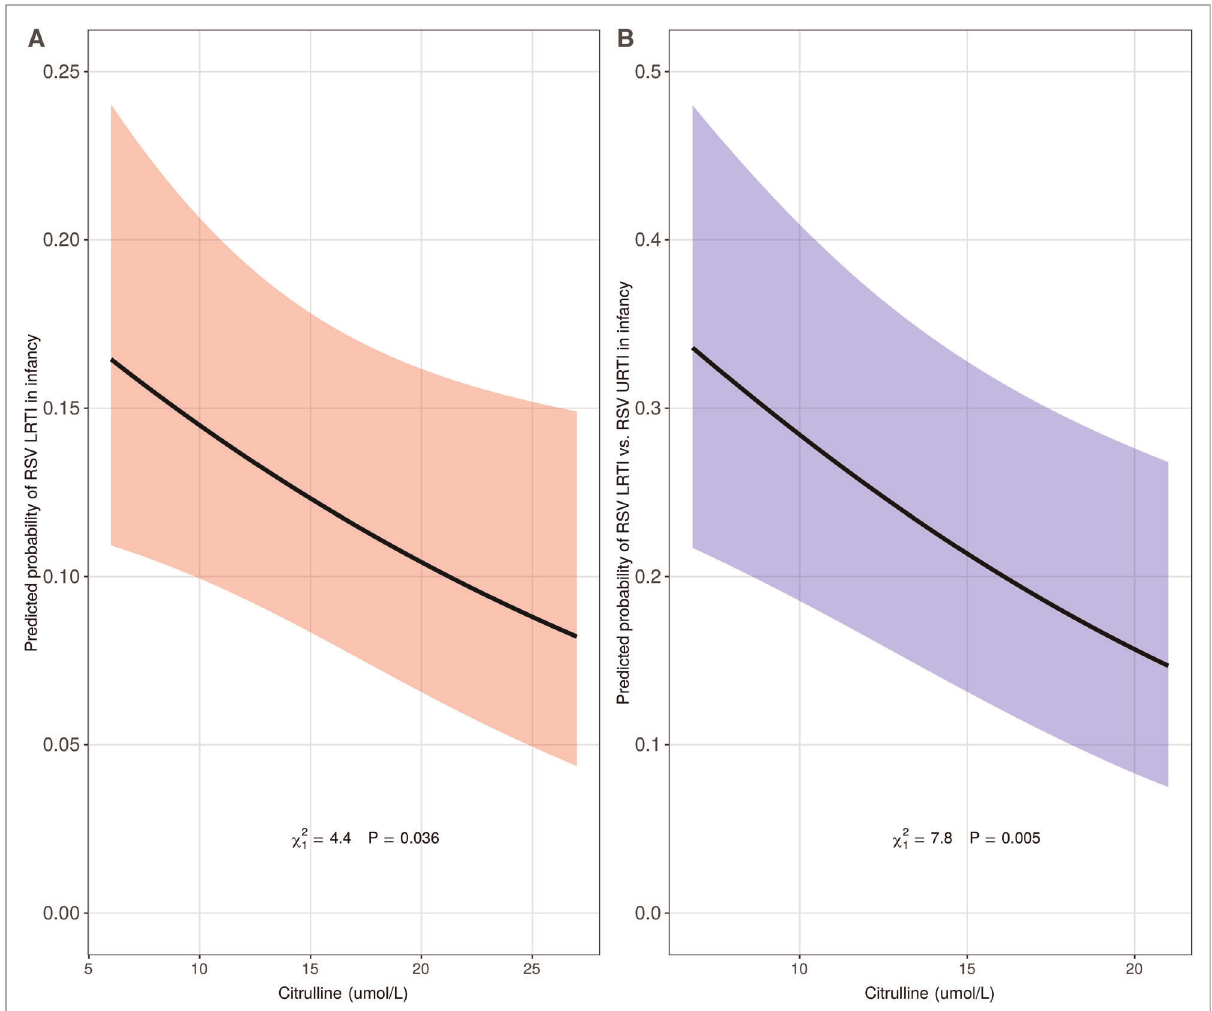
FIGURE 2 Association of citrulline concentration at birth with lower respiratory tract infection (LRTI) of all etiologies (panel A, n =1746) and respiratory syncytial virus (RSV) LRTI (panel B, n =912) in infancy in the discovery cohort. The predicted probability (y-axis) in panel A was calculated using a multivariable logistic regression model in the discovery cohort, INSPIRE, adjusting for infant sex, infant race/ethnicity, mode of delivery, maternal smoking during pregnancy, ever breastfed, maternal asthma, living siblings, daycare attendance during the fi rst year of life, and all other identi fi ed metabolites (C2, C3, C5, C5:1, C6-DC, C10:1, C10:2, C16, C18:2, ASA, GLY, ORN, SUAC, and VAL). The predicted probability (y-axis) in panel B was calculated using a multivariable logistic regression model in a subset of infants in INSPIRE with either RSV upper respiratory tract infection (URTI, less severe) or RSV LRTI (more severe), adjusting for infant sex, infant race/ethnicity, mode of delivery, maternal smoking during pregnancy, ever breastfed, maternal asthma, living siblings, and daycare attendance during the fi rst year of